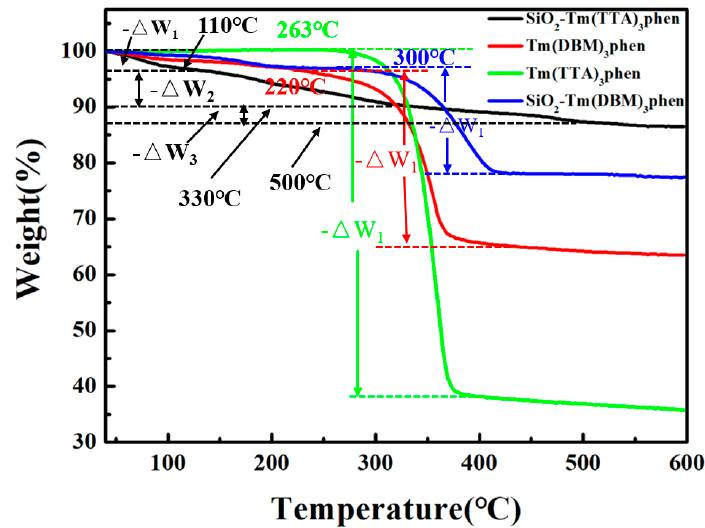
Figure 6. TGA curves of SiO 2 -Tm(DBM) 3 phen, SiO 2 -Tm(TTA) 3 phen, Tm(TTA) 3 phen, and Figure6. TGAcurvesofSiO 2 -Tm(DBM) 3 phen,SiO 2 -Tm(TTA) 3 phen,Tm(TTA) 3 phen,andTm(DBM) 3 phen Tm(DBM) 3 phen in nitrogen atmosphere(10 °C/ min). in nitrogen atmosphere(10 ◦ C /